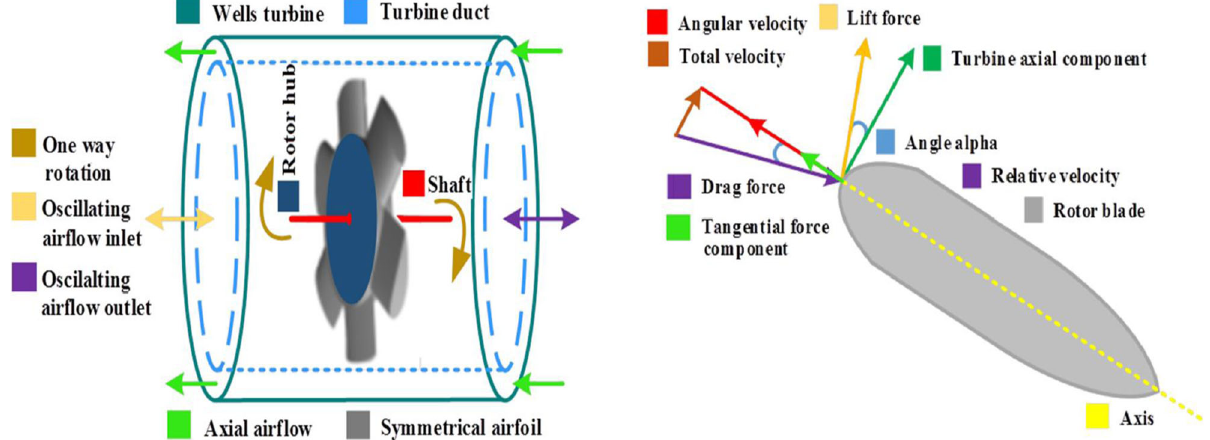
Fig. 2 Wells turbine concept and illustration of acting components on a turbine rotor blade. a Schematic representation of the Wells turbine. b Representation of aerodynamic